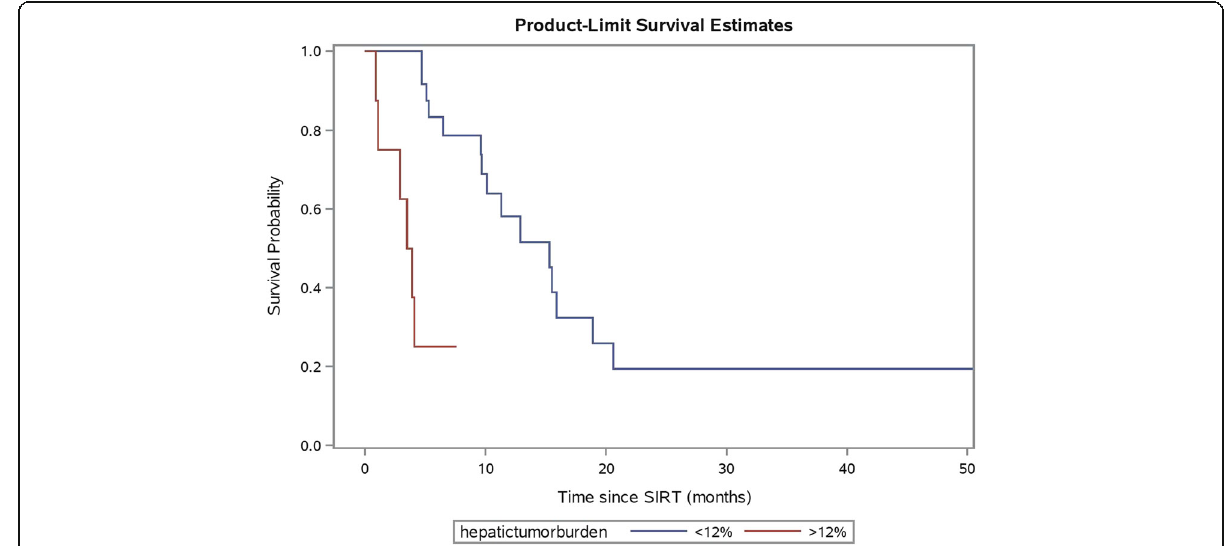
Fig. 8 Kaplan-Meier plot of patient survival with patients dichotomised into low ( ≤ 12%) and high (>12%) hepatic tumour burden groups as measured by MeVis. Patients with hepatic tumour burden ≤ 12% had improved survival compared to those with higher hepatic tumour burden ( p < 0.0001 by log-rank